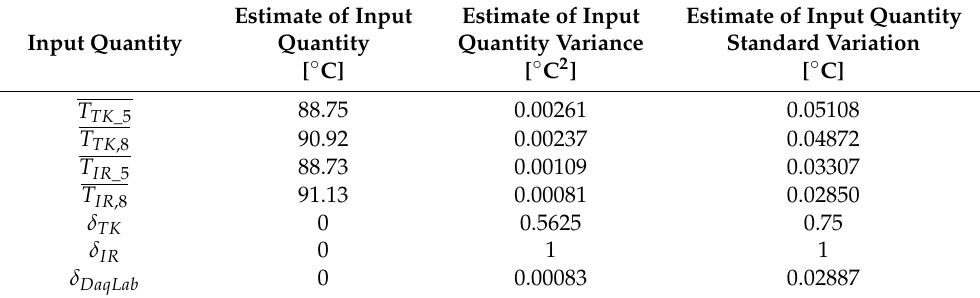
Table 2. Values of input quantities and statistical parameters.